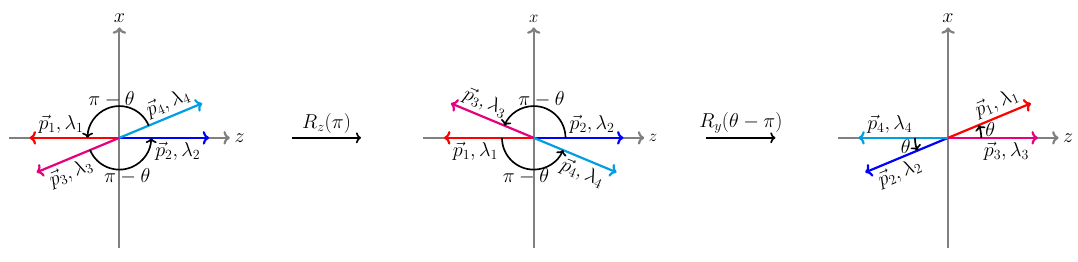
Figure 8 . The geometric picture involved in going from (B.60) to (B.64). Particle 1 is red, particle 2 is blue, particle 3 is magenta and particle 4 is